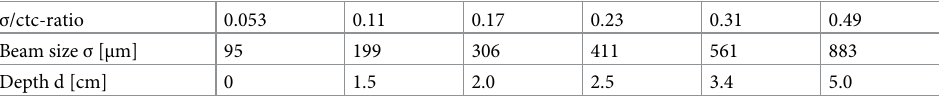
Table 3. Corresponding depths to the irradiated σ /ctc-ratios and beam sizes for an exemplary tumor in 5–8.5 cm depth. σ